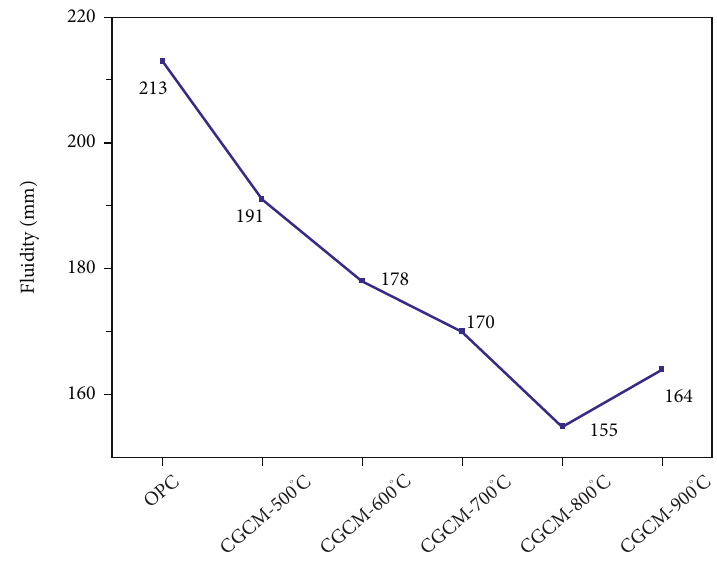
Figure 3: E ff ect of calcination temperature on the initial fl ow rate of CGCM